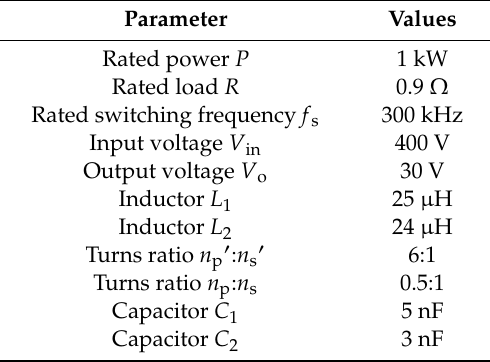
Figure 14. Experimental prototype of the proposed converter. Table 2. Main Parameters of the CLTLC (capacitor-inductor-transformer-inductor-capacitor) converter.